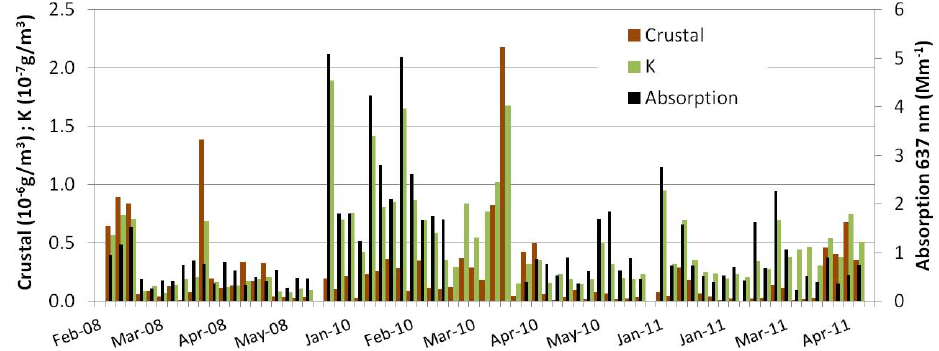
Fig. 5. Aerosol particle mass concentrations of fine mode (PM 2 ) crustal elements (Al, Si, Ti, Fe, in 10 − 6 gm − 3 ) and potassium (K, in 10 − 7 gm − 3 ), and particle absorption coefficients at 637nm averaged according to filter integration times. Only data between January and May of each year is shown.